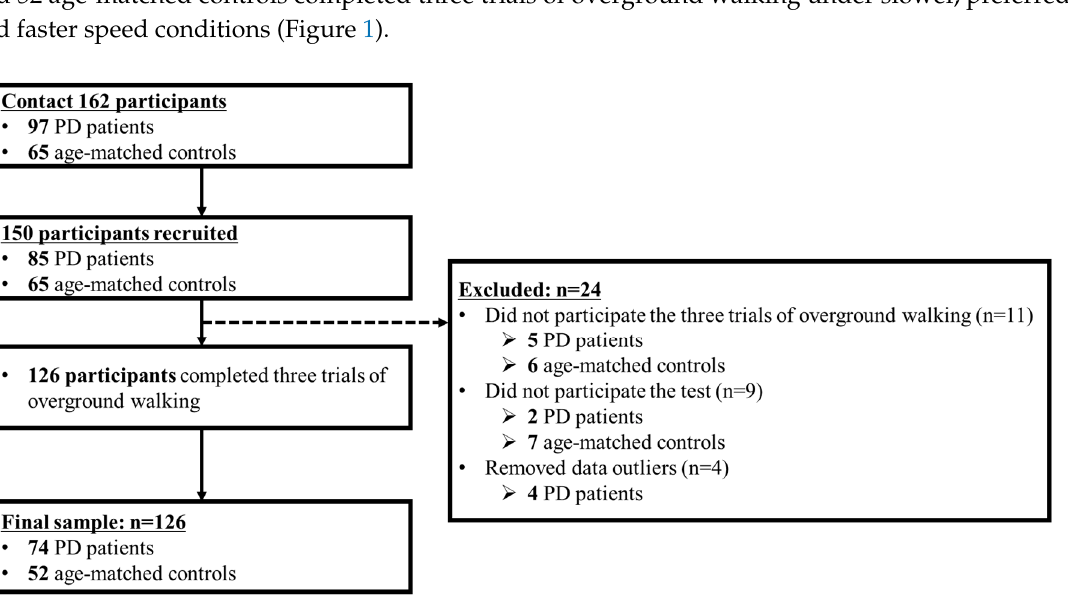
Figure 1. Recruitment process flowchart.